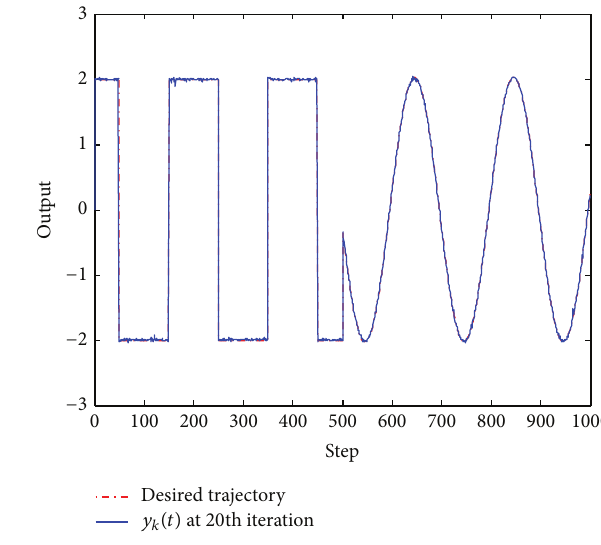
Figure 3: System output at 20th iteration.